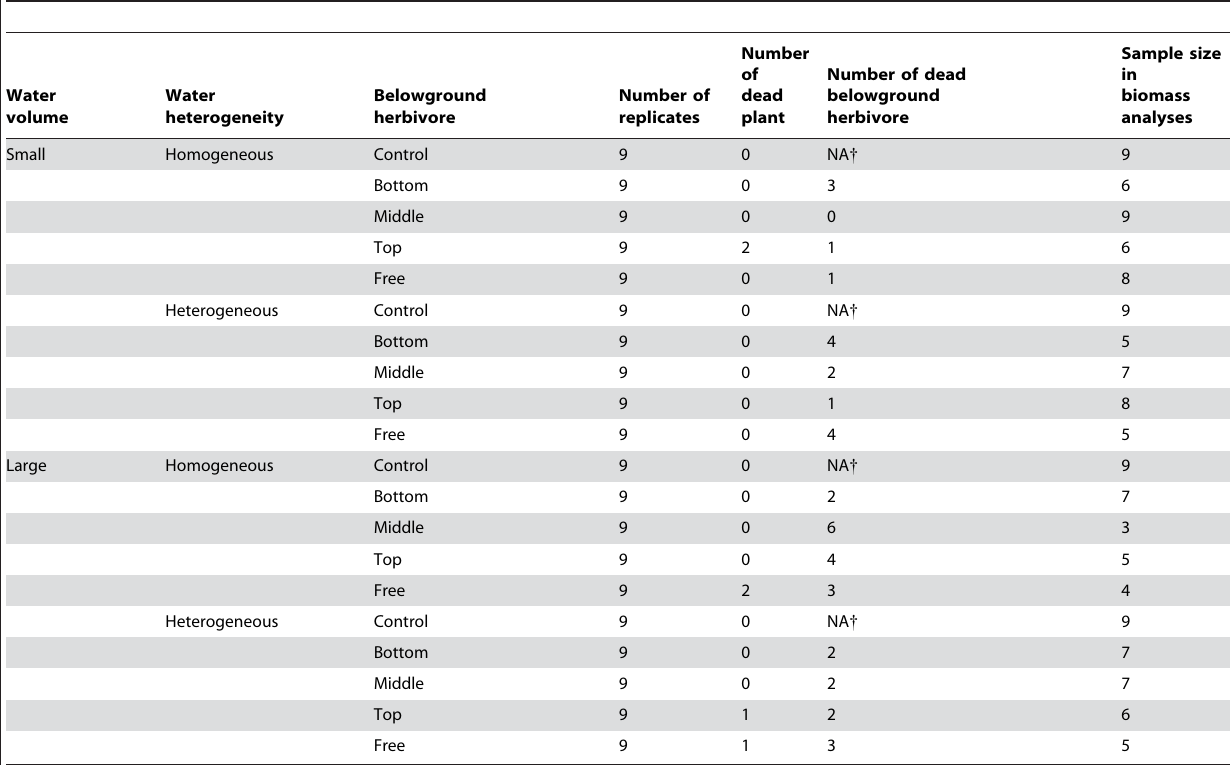
Table 1. Number of replicates, dead plants, and dead belowground herbivores, and the total sample size in biomass analyses of combinations of experimental